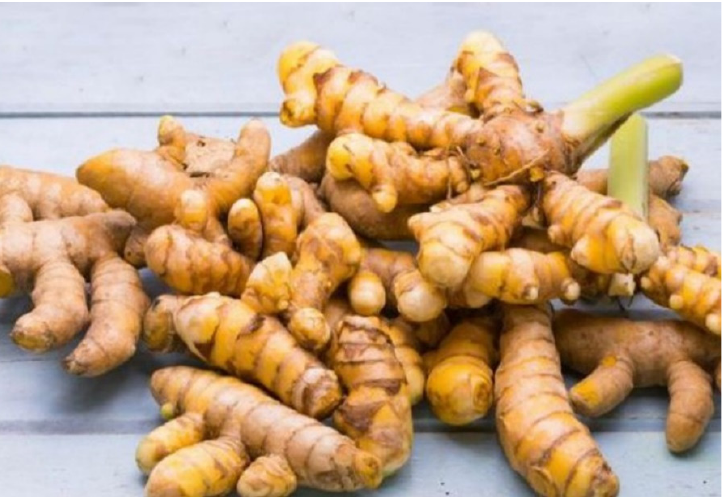
Figure 3. Curcuma longa